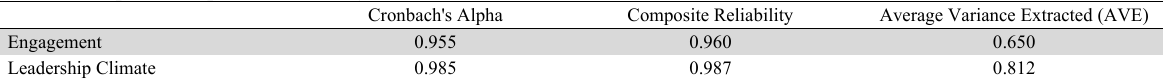
Cronbach Alpha, Composite Reliability, AVE